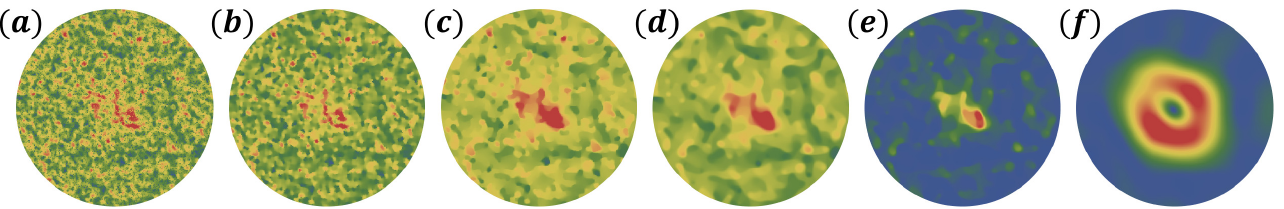
Figure 6. First segment estimation stages (Algorithm 3): ( a ) original pre-processed (Algorithm 2) image; ( b ) PM-filtered image; ( c ) Poisson TV-filtered image; ( d ) SSCF-filtered image; ( e ) SCTMM output; ( f ) gradient filter output (edge halos); ( g ) hysteresis-segmented edge halos (prior to erosion); ( h ) bubble masks obtained after erosion, thinning, filling, small-radius mean filtering, Otsu binarization and border component removal. The color scheme is as in Figure 1.